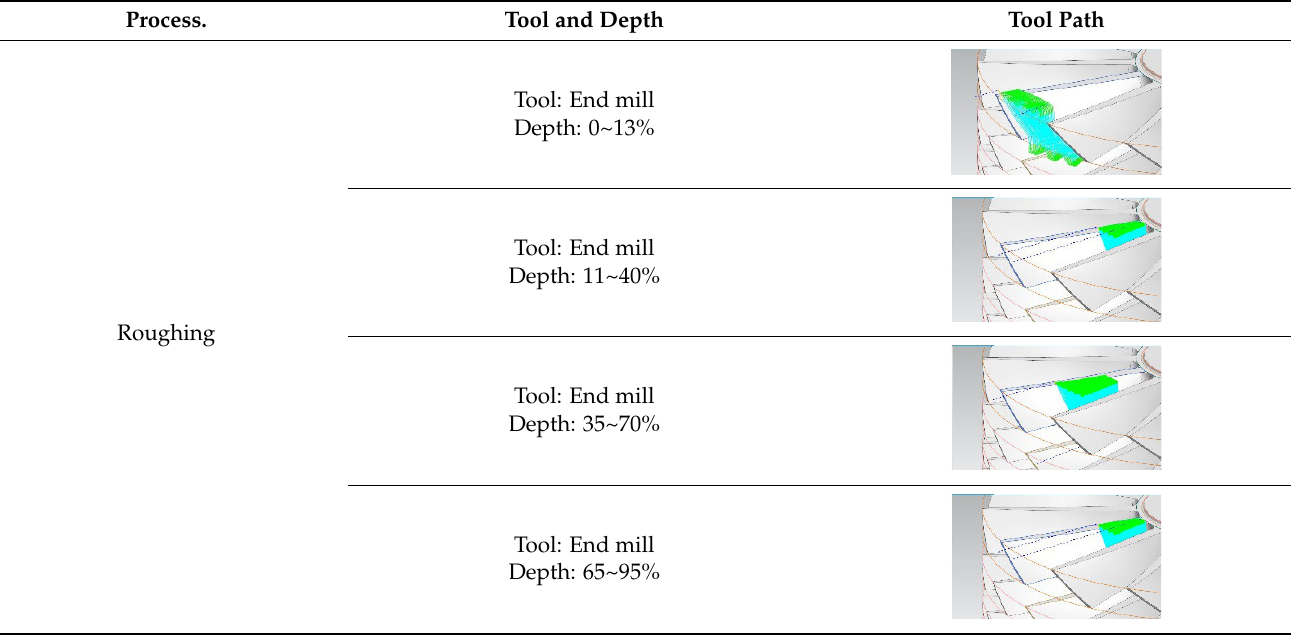
Table 1. Toolpath planning for of the turbomolecular pump rotor. Process. Tool and Depth Tool Path